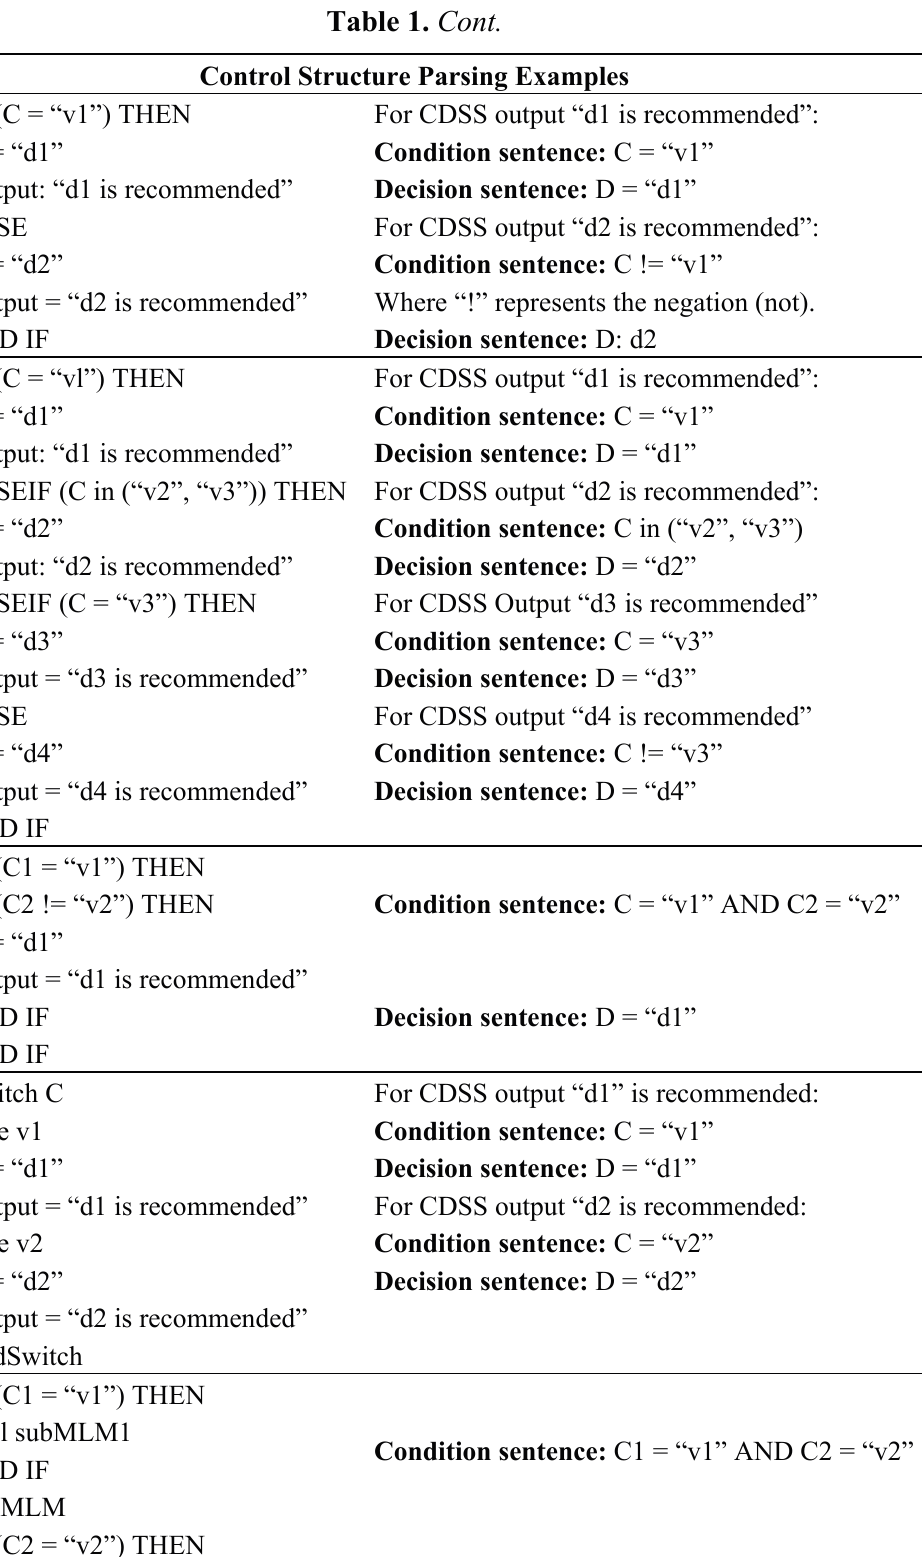
Table 1. Cont. Control Structure Parsing